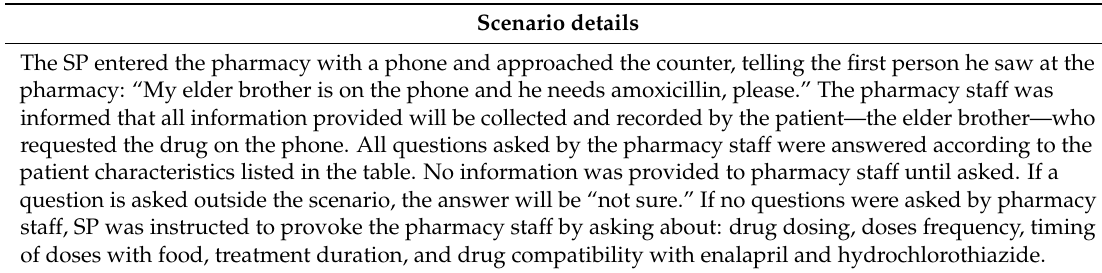
Table 6. Details of simulated patient